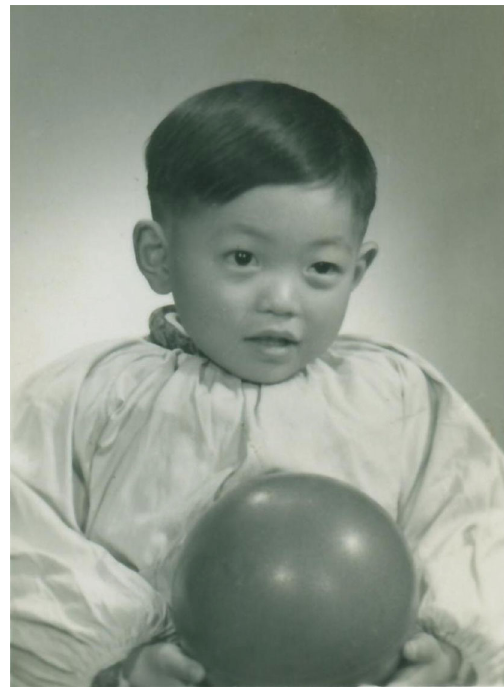
Figure 2. Dr. Jian Zhou ’ s childhood photo.